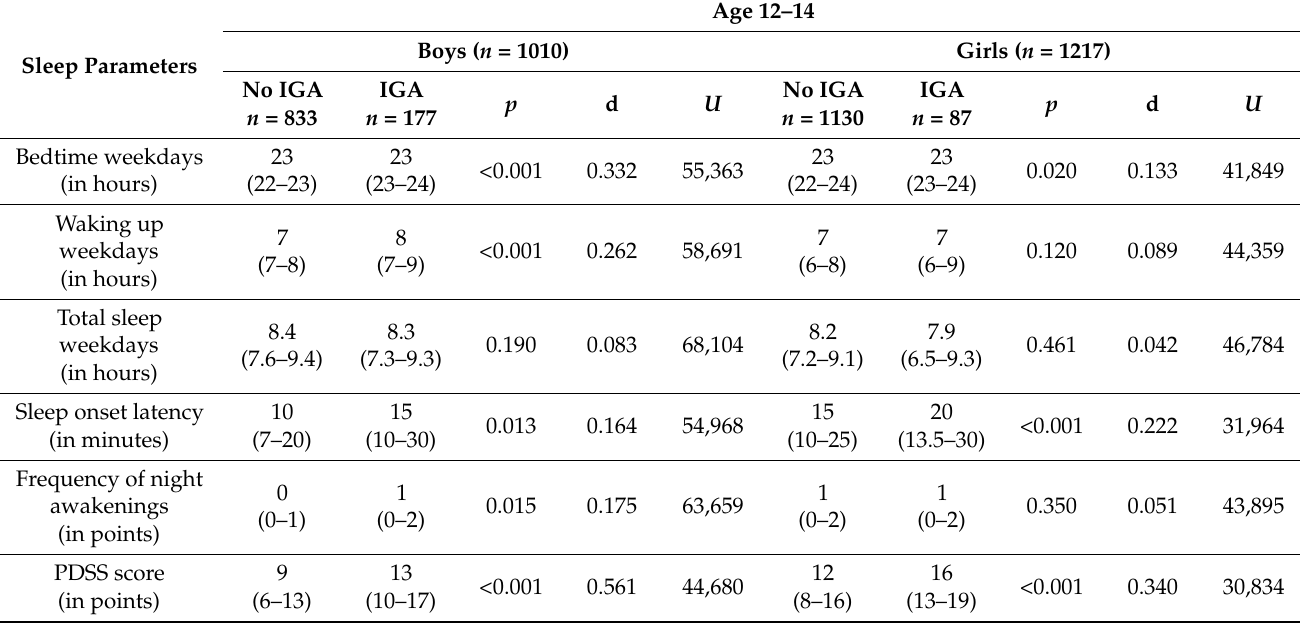
Table 5. Sleep parameters in adolescents aged 12–14 with Internet game addiction (IGA) verified with Game Addiction Scale for Adolescents